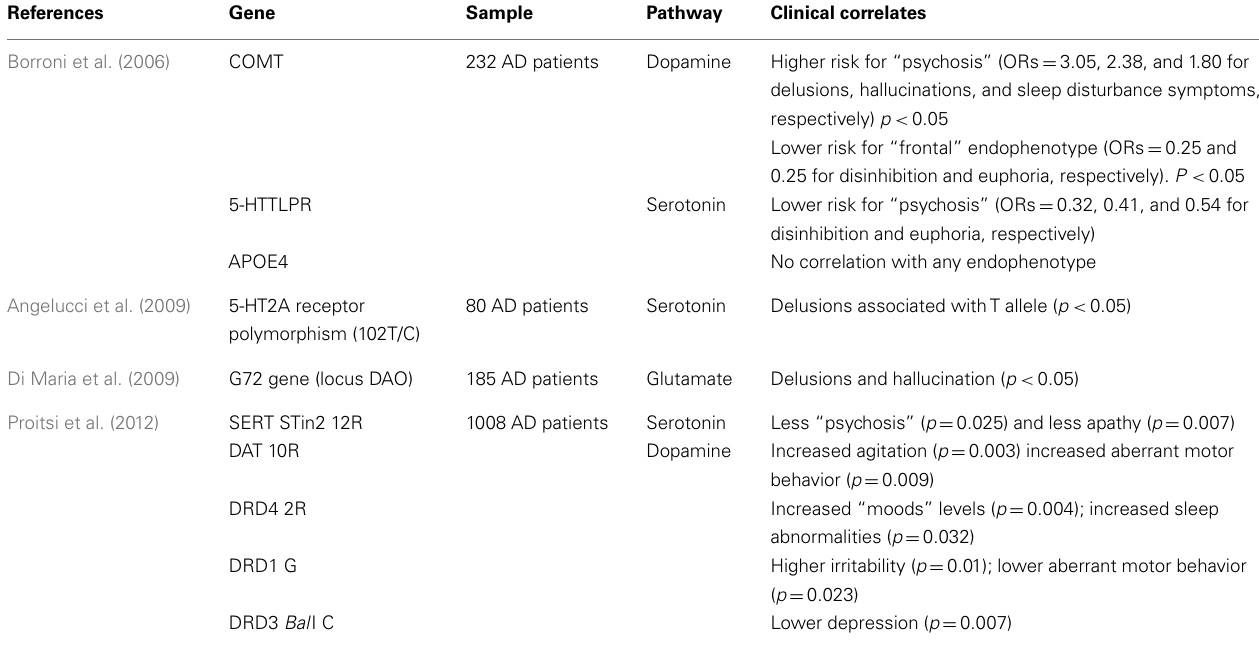
Table 8 |Associations between BPSD and